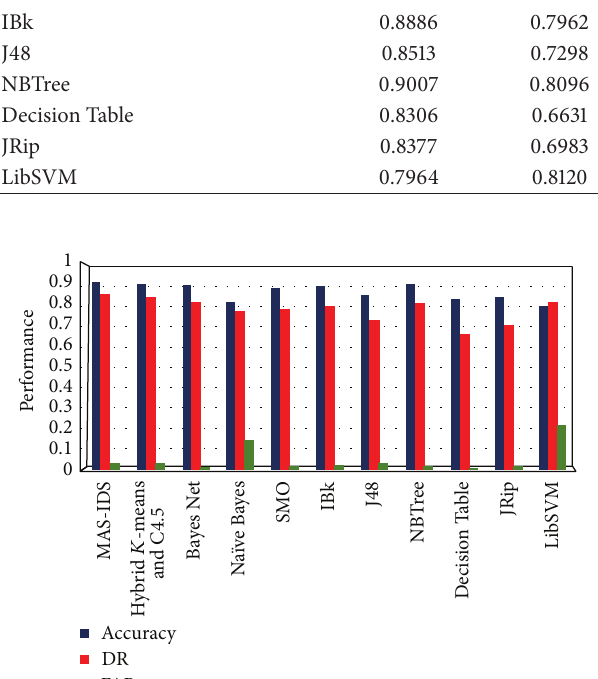
Figure 8: Comparison performance of MAS-IDS with other meth- ods.